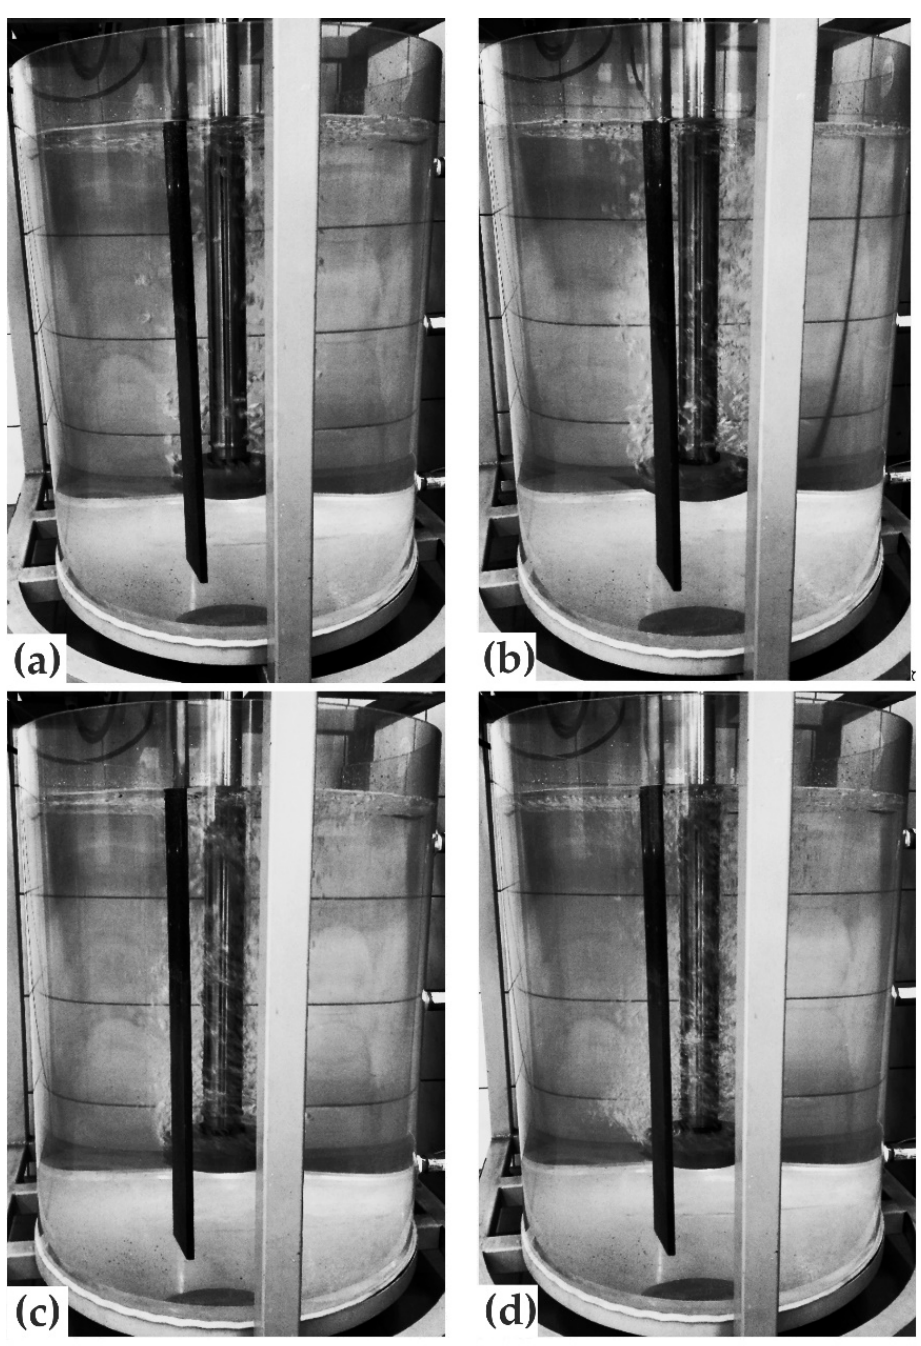
Figure 11. Impeller variant B4—gas bubbles dispersion registered for a gas flow rate of 10 dm 3 · min − 1 and rotor speed of ( a ) 200, ( b ) 300, ( c ) 400, and ( d ) 500